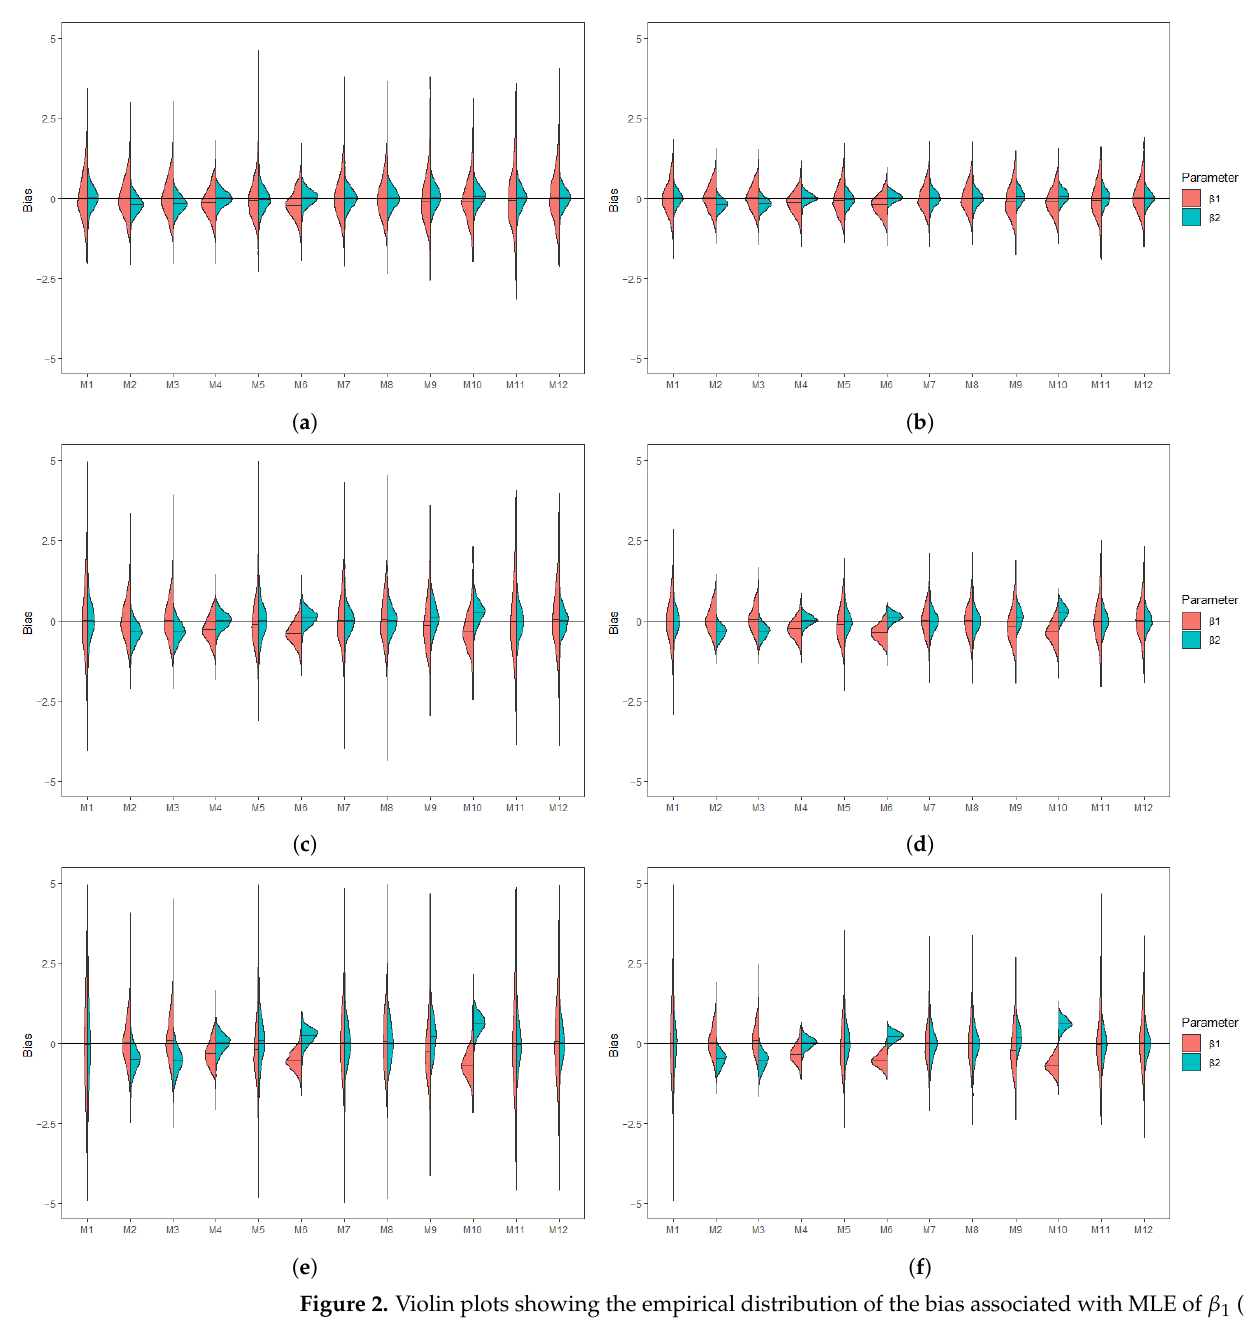
Figure 2. Violin plots showing the empirical distribution of the bias associated with MLE of β 1 (red) and β 2 (green) when covariates are correlated and X ∗ , j = 1,2 is subjected to lower LOD. ( a ) Bias ij under n = 50 and m 1 = m 2 = 20%. ( b ) Bias under n = 100 and m 1 = m 2 = 20%. ( c ) Bias under n = 50 and m 1 = m 2 = 40%. ( d ) Bias under n = 100 and m 1 = m 2 = 40%. ( e ) Bias under n = 50 and m 1 = m 2 = 60%. ( f ) Bias under n = 100 and m 1 = m 2 =